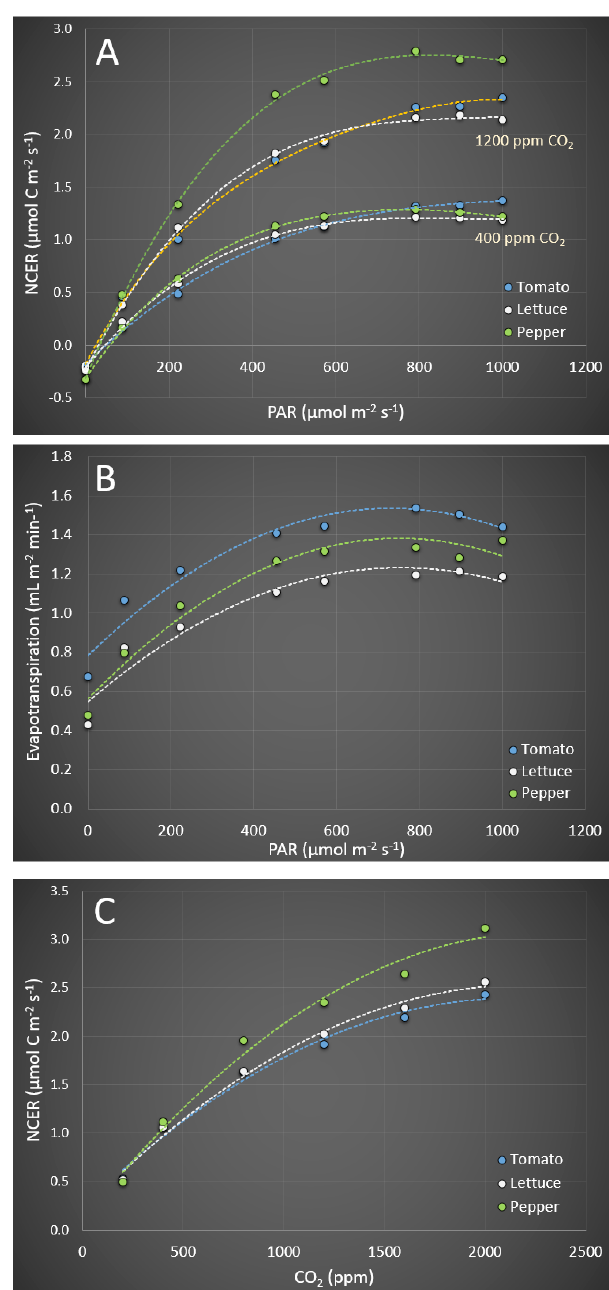
Figure 6: Preliminary capability data of the PS1000 analytical plant growth chamber. A) Changes in net photosynthesis in response to increasing concentrations of ambient carbon dioxide. As long as light is not limiting, more carbon dioxide = faster growing plants; B) Change in the rate of evapotranspiration in response to increasing irradiance. Higher light = increased photosynthesis = increased water use; C) Changes in net photosynthesis in response to increa- sing irradiance. Light curves help identify the optimal light intensity for growth. Tomato and pepper are able to utilize higher intensities of light than lettuce